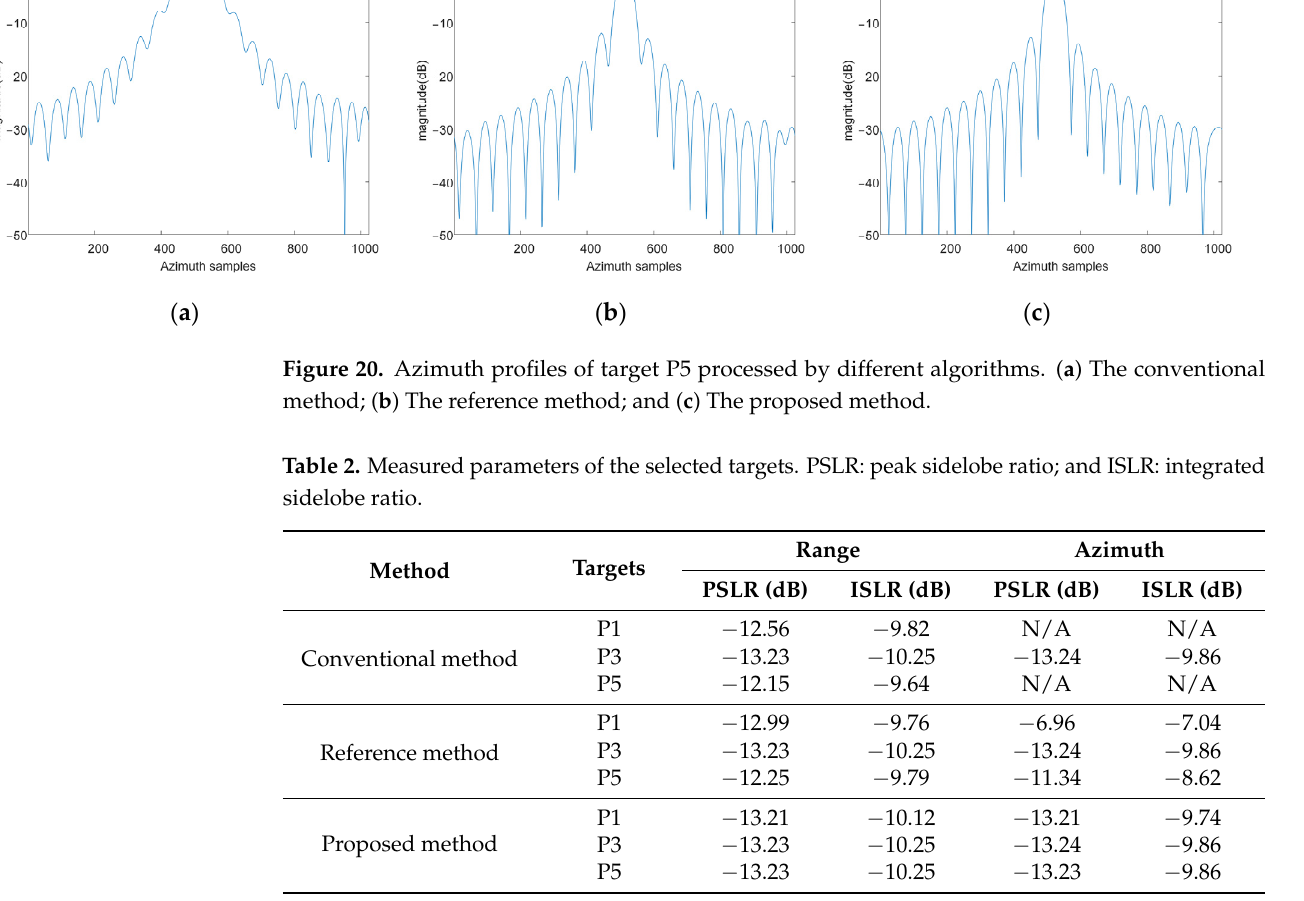
method; ( b ) The reference method; and ( c ) The proposed method.